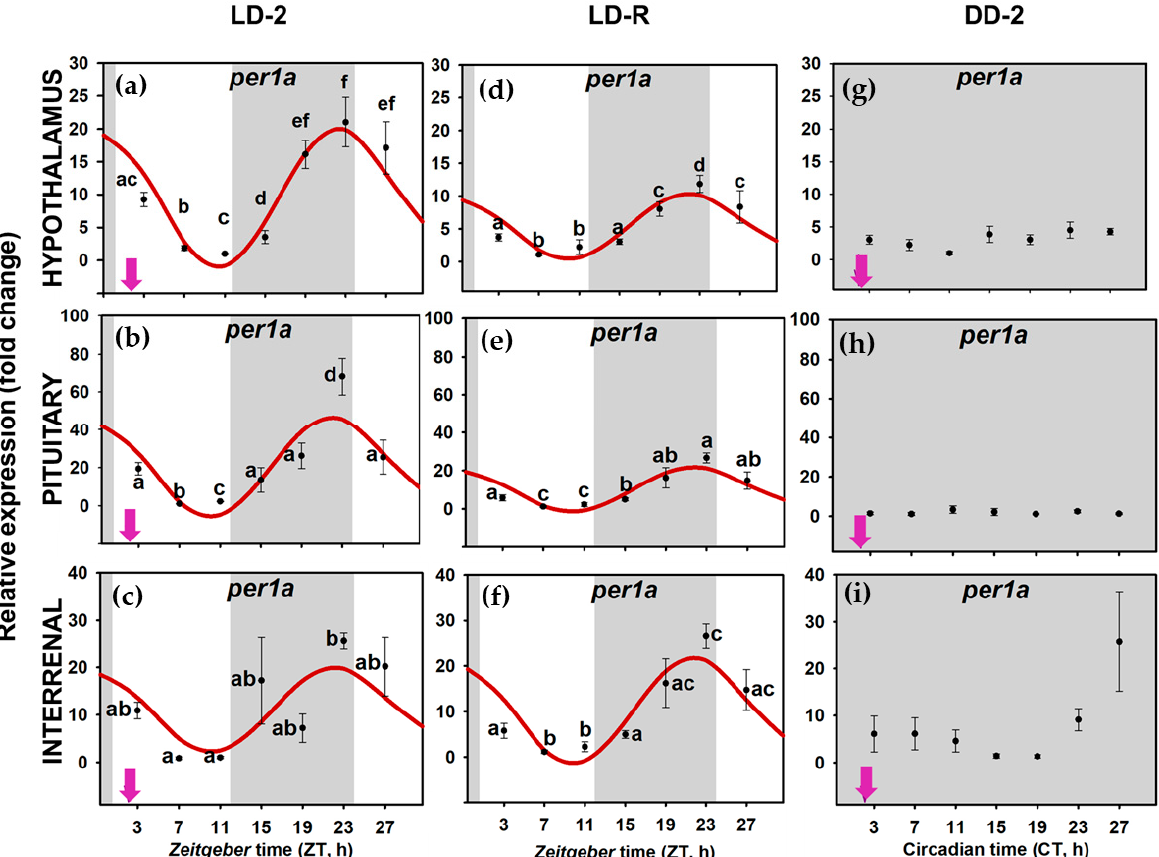
Figure 4. Relative expression of period 1a (per1a) in hypothalamus ( a , d , g ), pituitary ( b , e , h ) and interrenal tissue ( c , f , i ) of goldfish. Data are expressed as mean ± standard error (n = 8). Grey areas indicate the darkness period, and arrows point to the feeding time when it was scheduled ( zeitgeber time 2 (ZT 2). Different letters show significant differences among groups (ANOVA and Student–Newman–Keuls (SNK) test). The curves show sinusoidal periodic functions obtained by cosinor analysis when it was significant (noise/signal < 0.3).